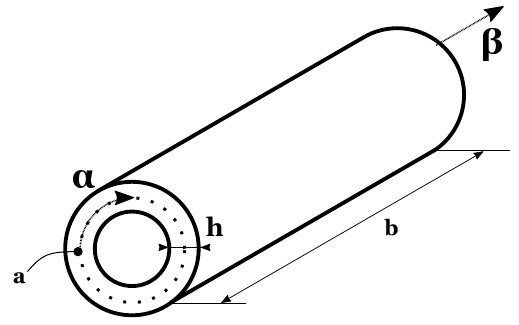
Figure 4. The cylinder geometry for Case